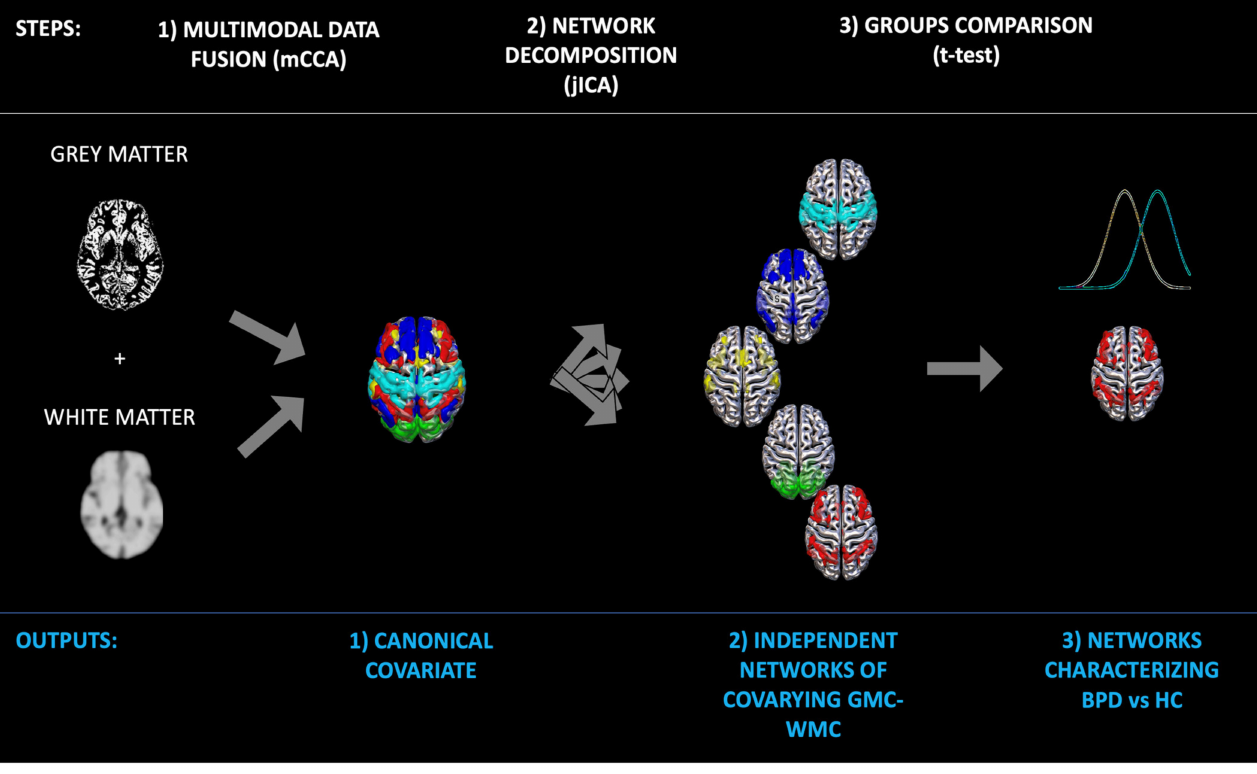
Figure 1. Schematic workflow of the analyses . After fusing the two modalities (GM and WM), the brain was decomposed into independent networks of covarying GM-WM (mCCA+jICA). Then Bonferroni corrected t -test was used to assess the networks that differed between